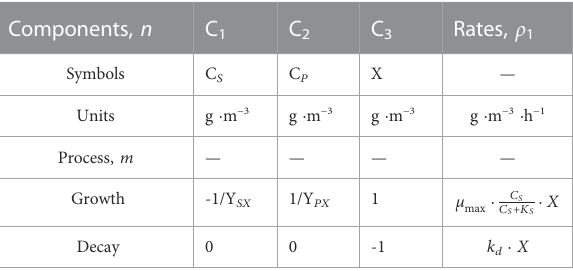
TABLE 2 Matrix presentation of a Monod-Herbert anaerobic biomass growth model. With variables: substrate concentration, C S ; product concentration, C P ; biomass concentration, X. The parameters in the matrix are: biomass yield on substrate, Y SX ; biomass yield on product, Y PX ;